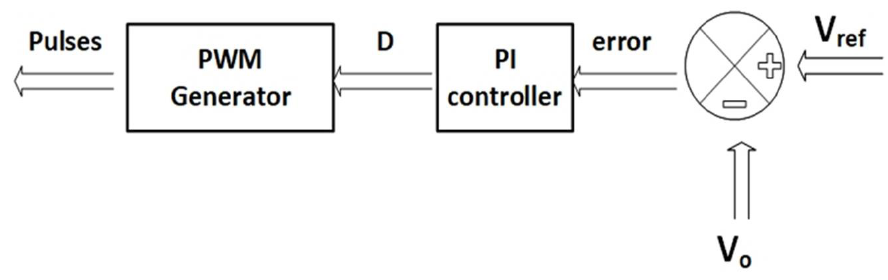
Figure 10. Converter controller.